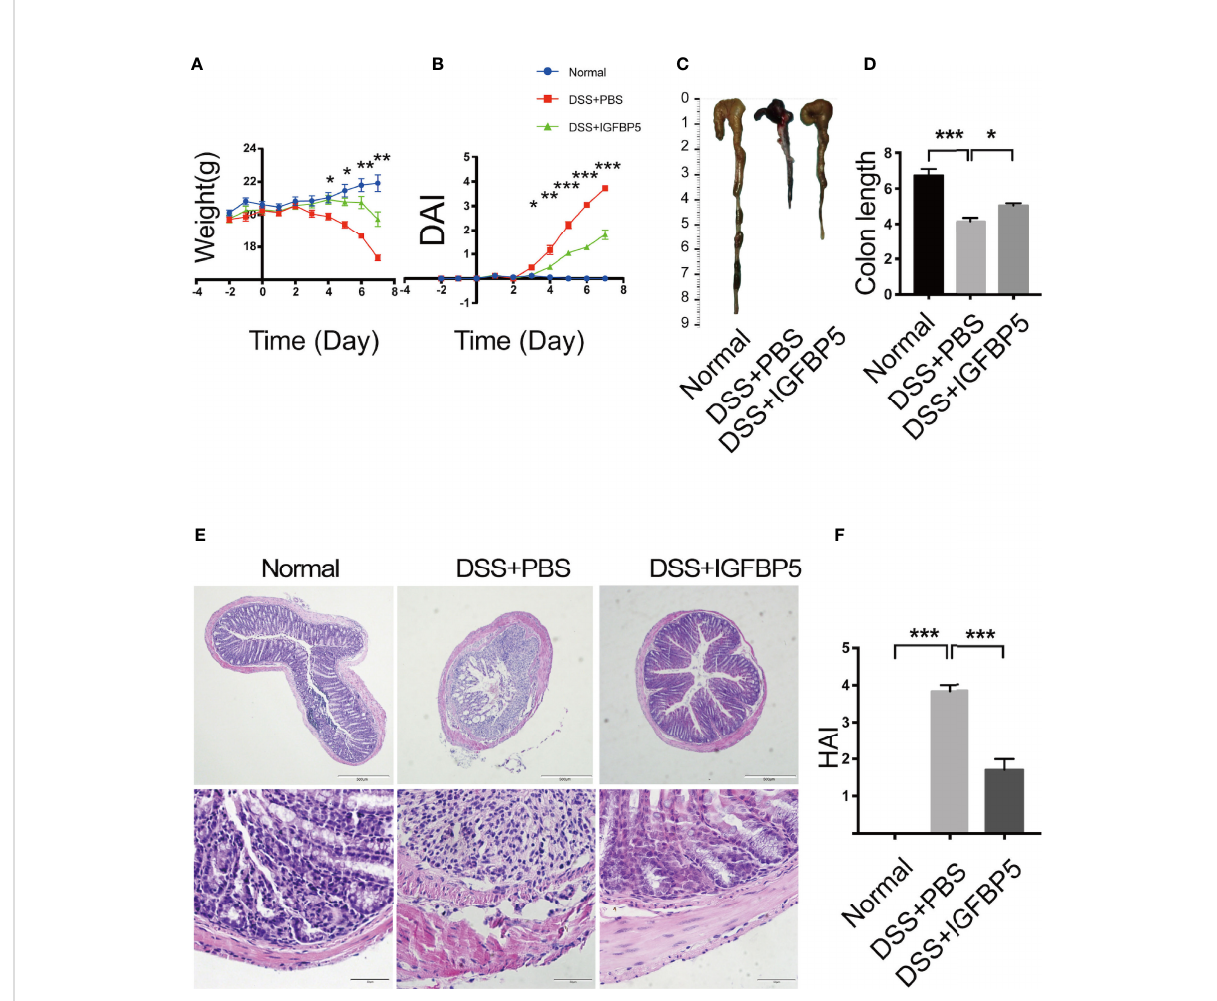
FIGURE 2 IGFBP5 ameliorated DSS-induced colitis in mice. (A) Daily body weight during the experiment. (B) Disease activity index (DAI) every day during the experiment. (C) Representative photo of the colon in each group and (D) Quantitative analysis of colon length in each group (n=5).